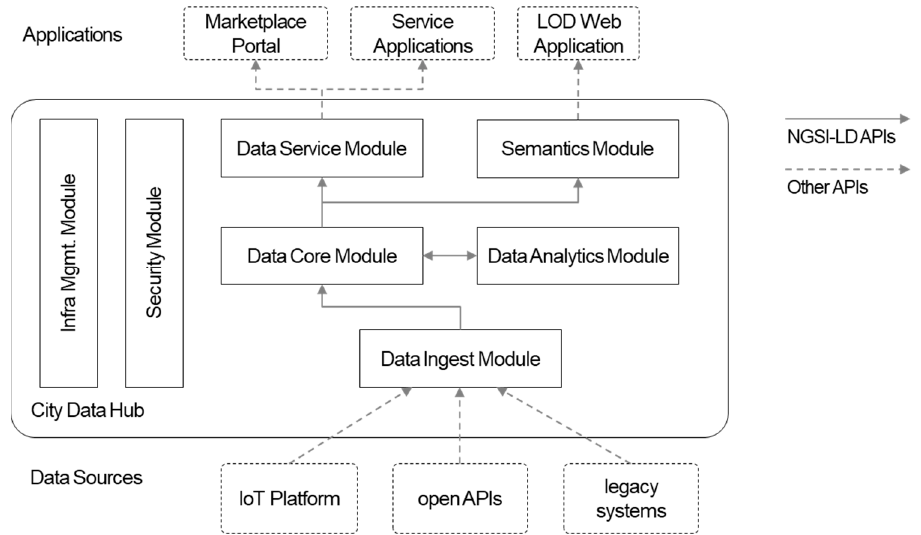
Figure 2. City Data Hub high-level architecture with data flows.